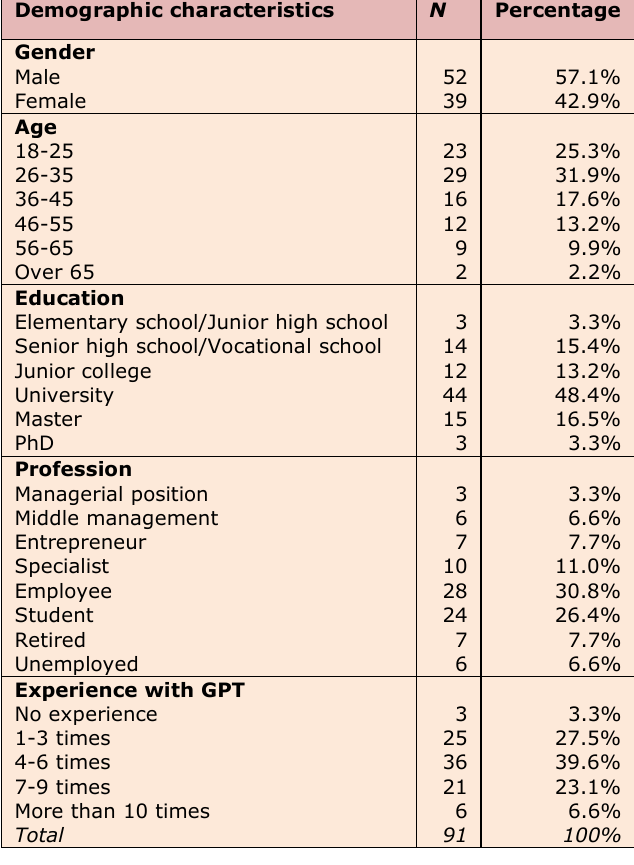
Table 1. Profile of respondents ( N